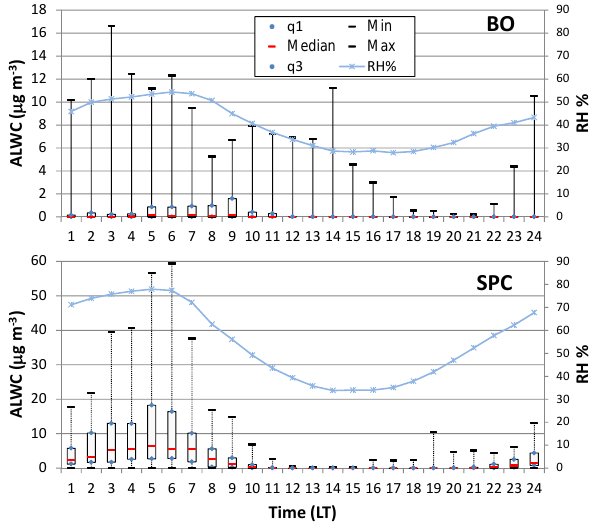
Figure 7. Box plot of average diurnal variation of aerosol liquid wa- ter content (ALWC) with superimposed diurnal variation of relative humidity (RH) during the campaign. Please note the different scale of ALWC at the two sites. The labels q1 and q3 in the box plot, respectively, denote the first and the third